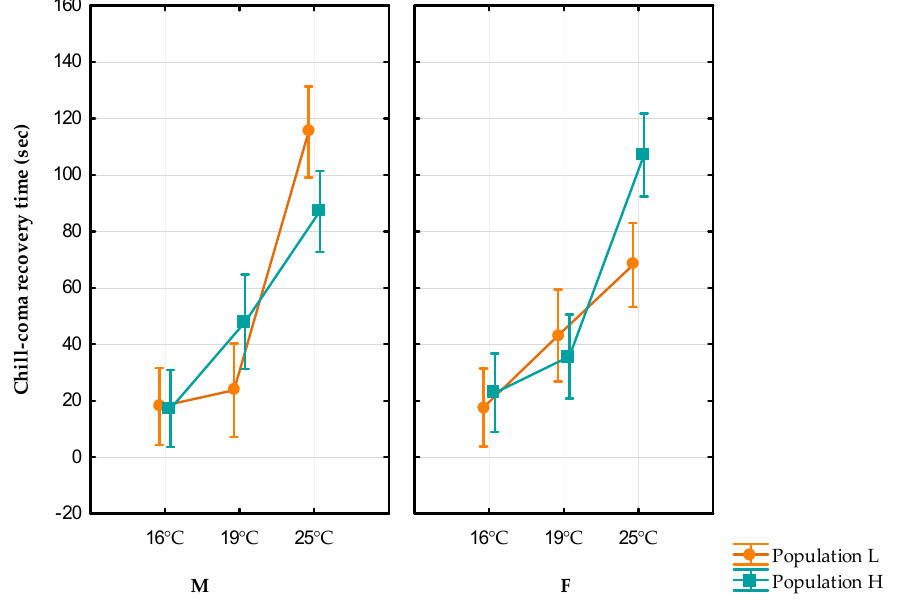
Figure 4. Results of the full factorial GLM analysis for chill coma recovery time with fixed factors population, rearing temperature, and sex. Vertical bars denote 0.95 confidence interval. M—males; F—females; L—population originating from lower altitude; and H—population originating from a higher altitude.